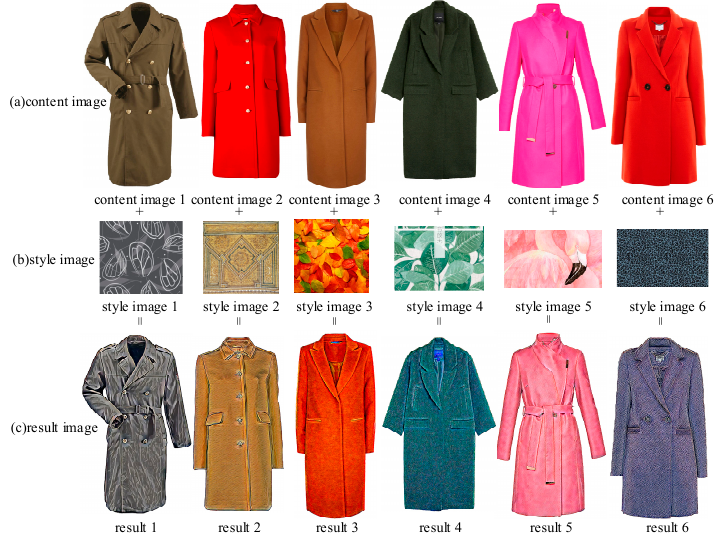
Figure 7. Product designs based on neural style transfer. ( a ) The content images. ( b ) The style images. ( c ) The results. We inputted ( a , b ) into the style transfer model, after simple processing, such as removing background color not related to the product, to obtain the results ( c ). The results retained the shape of ( a ), while obtaining details such as color and pattern similar to ( b ).